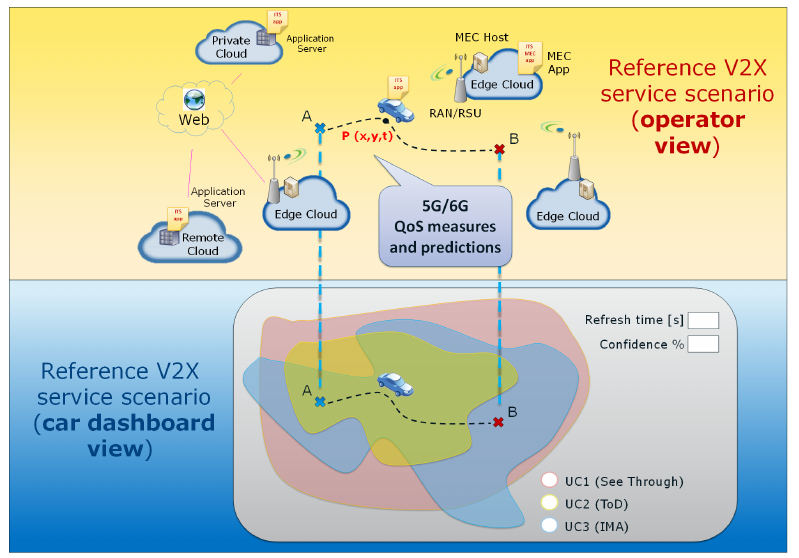
Figure 6. Reference V2X service scenarios, with MNO perspective and customer/car OEM